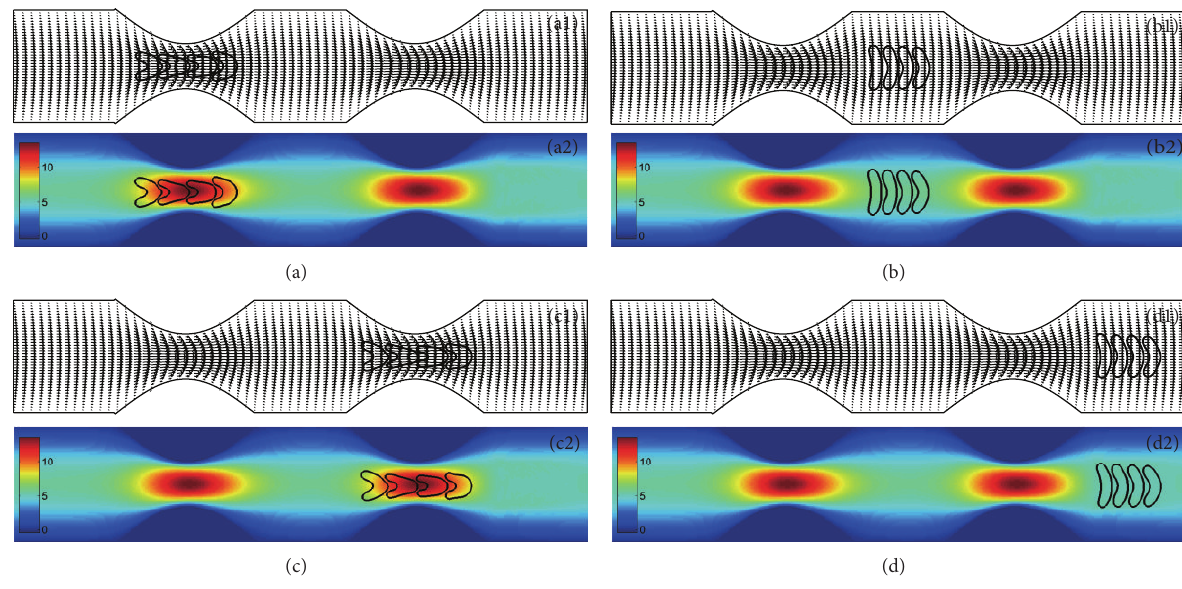
Figure 13: Motion and dissociation of a four-cell erythrocyte aggregate which is vertically placed in a 8 𝜇 m sinusoidal shaped stenosis at time instants (a) 𝑡 = 0.40 ms; (b) 𝑡 = 0.69 ms; (c) 𝑡 = 0.98 ms; and (d) 𝑡 = 1.27 ms. Velocity vectors (a1-d1) and axial velocity magnitude contours (cm/s) (a2-d2) are presented. The initial configuration for the aggregate is shown in Figure 1(c), and the aggregate is vertically placed in the channel initially. The parameters used are 𝐷 𝑒 = 1.0 × 10 −2 𝜇 J/m 2 , 𝑘 𝑏 = 5.0 × 10 −13